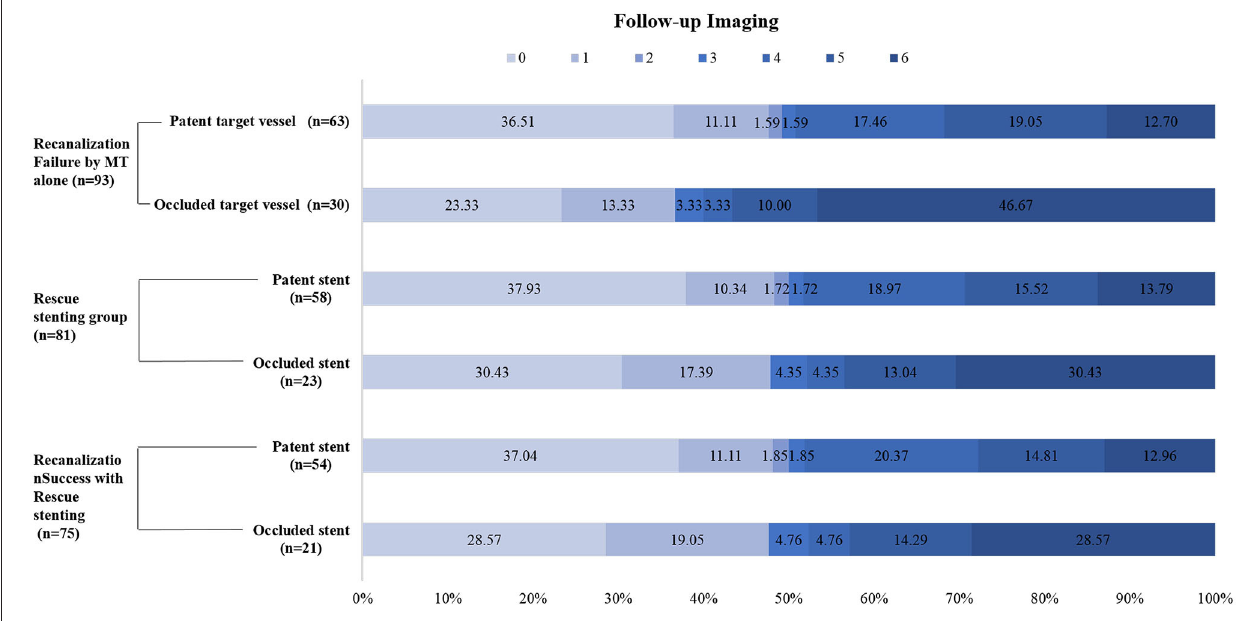
FIGURE 3 | Distributions of the 3-month modified Rankin Scale score (mRS) in MT-failed patients. MT indicates mechanical